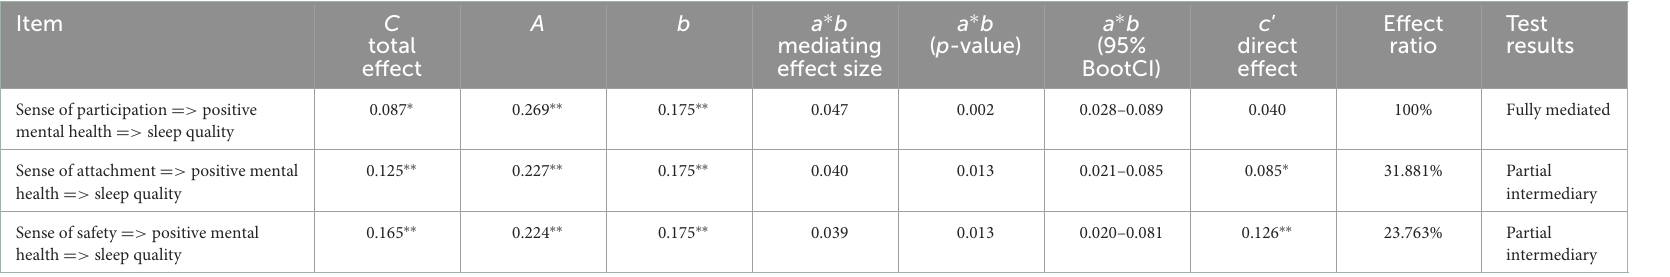
TABLE 11 Summary of the test results of social environment through the mediating effect of mental health.